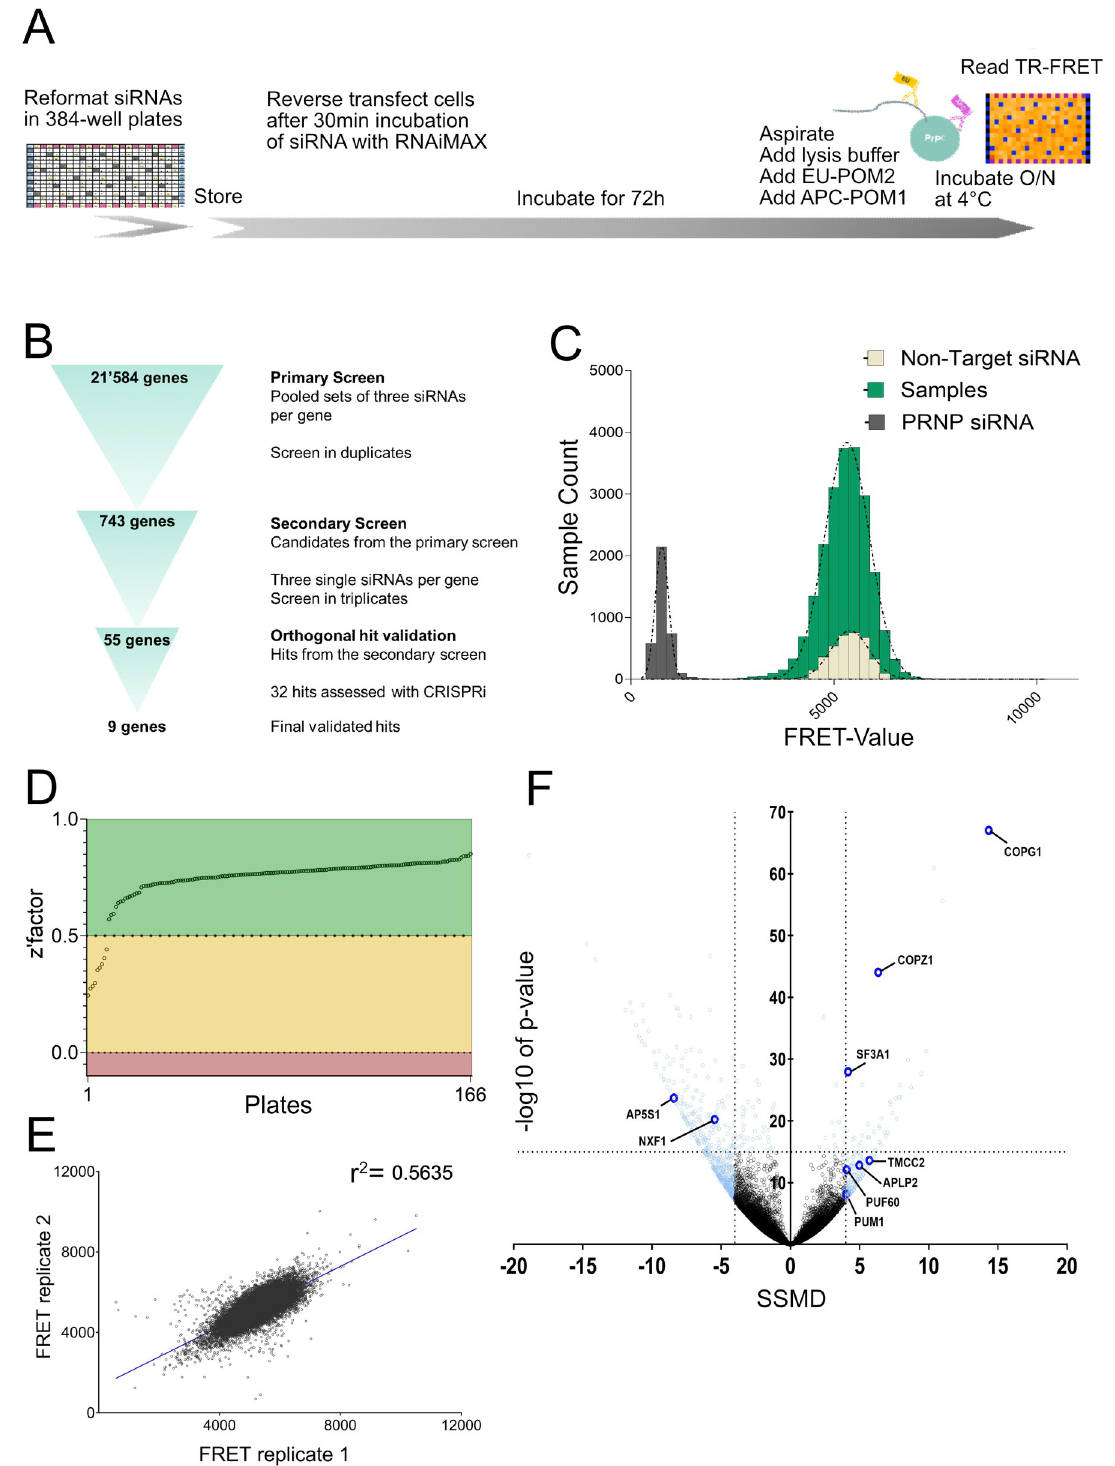
Fig 1. Workflow of the siRNA screen and primary screening round in U251-MG glioblastoma cell line. (A) Depiction of the screening workflow. (B) Hit selection process. (C) Distribution of populations of positive controls ( PRNP targeting siRNAs), negative controls (non-targeting siRNAs) and samples (contents of whole genome siRNA libraries) across FRET values. The x-axis represents PrP C levels measured with TR-FRET; the y-axis represents the number of assays grouped for the given FRET range. Controls showed a